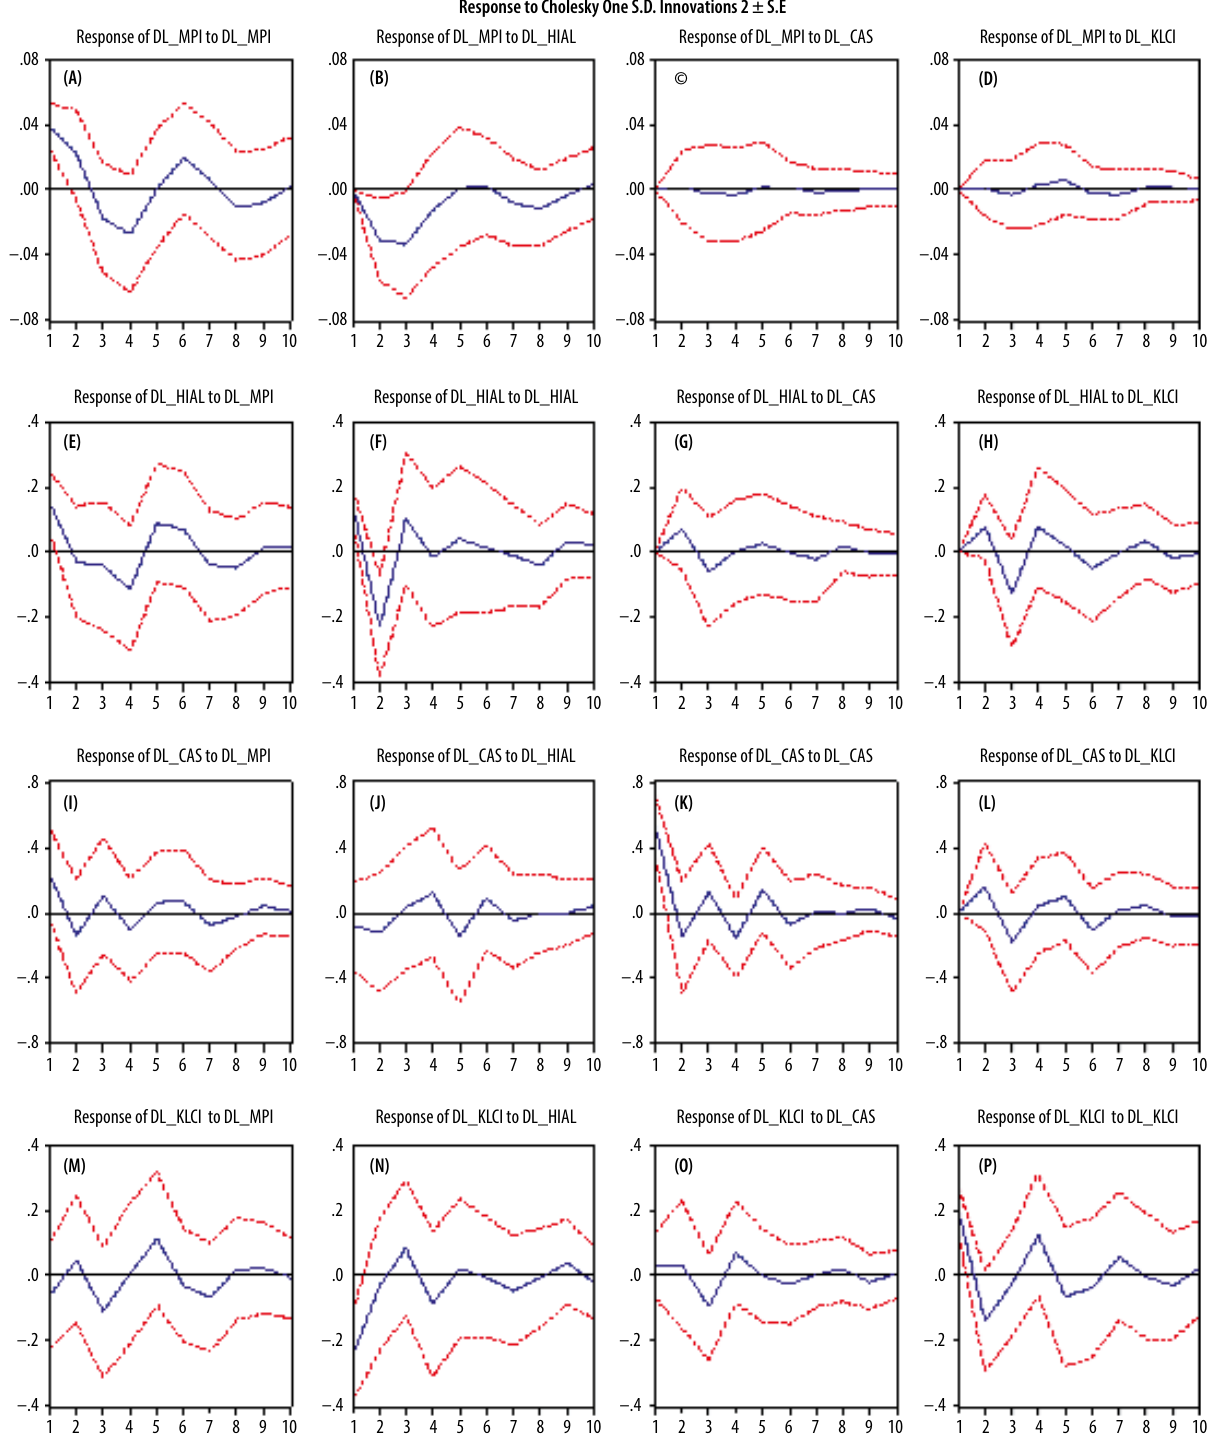
Fig. 2. Impulse response for innovations in unexpected equation